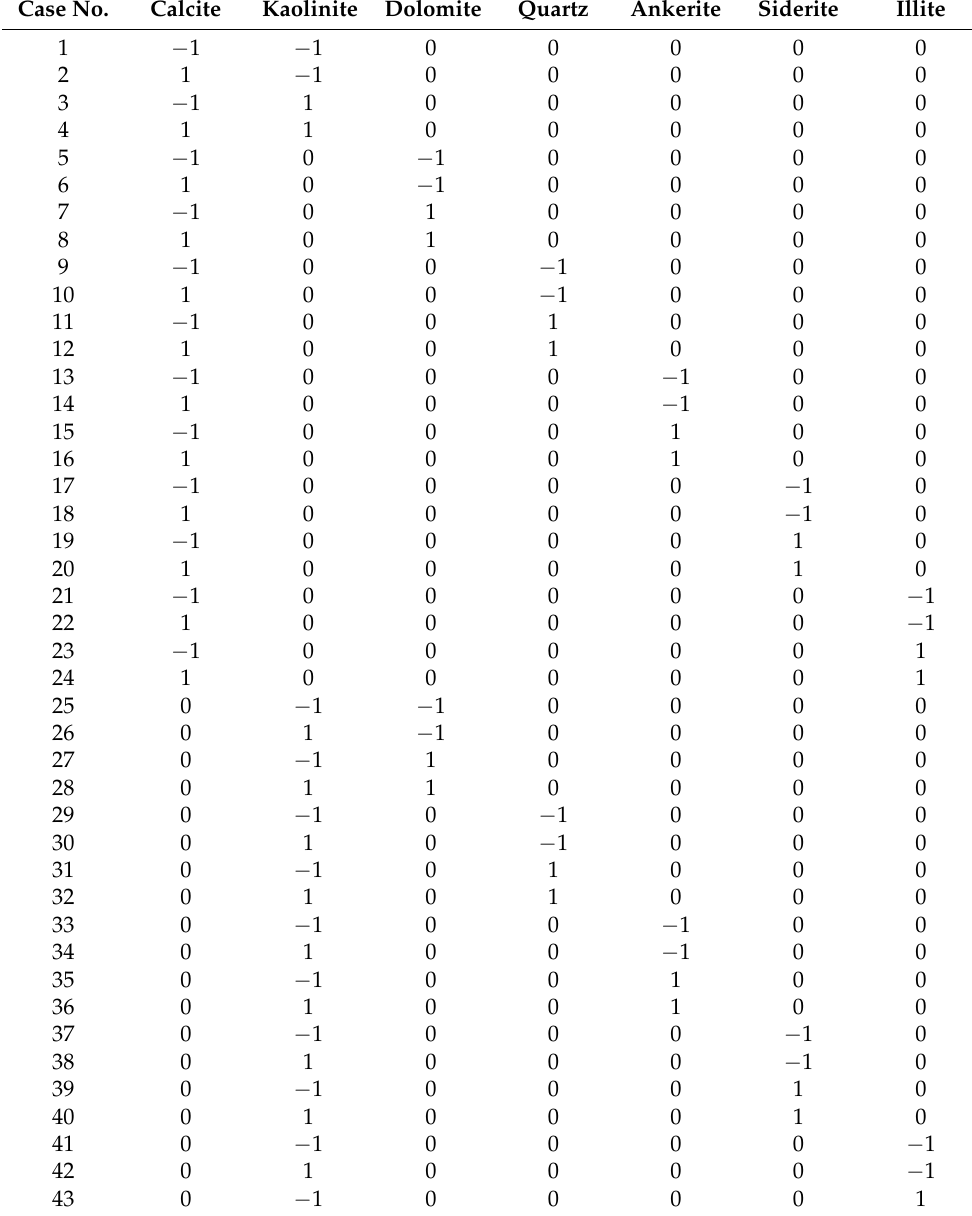
Table A1. List of cases consists of a seven-factor Box–Behnken design (low: − 1; mid: 0; high: 1) and two extreme permutations (all low values and all high